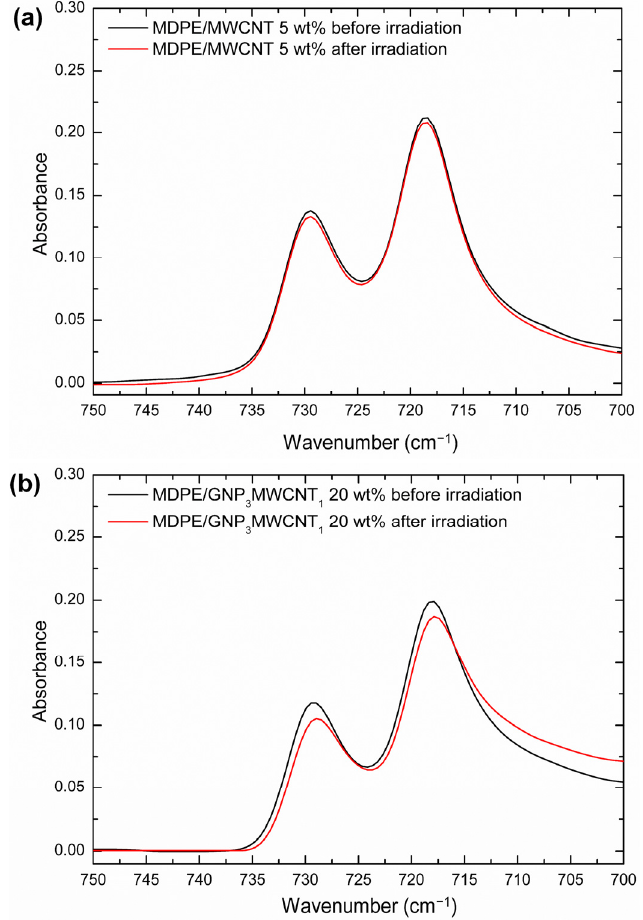
Figure 4. ATR-FTIR spectra of ( a ) MDPE/MWCNT 5 wt% and ( b ) MDPE/GNP 3 MWCNT 1 nanocomposites before and after proton irradiation in the 750–700 cm − 1 region. Table 3. Degree of crystallinity (X c ) and relative percentage variation ( ∆ X c /X c ) calculated from FTIR spectra of MDPE/GNP and MDPE/MWCNT nanocomposites at different filler concentrations